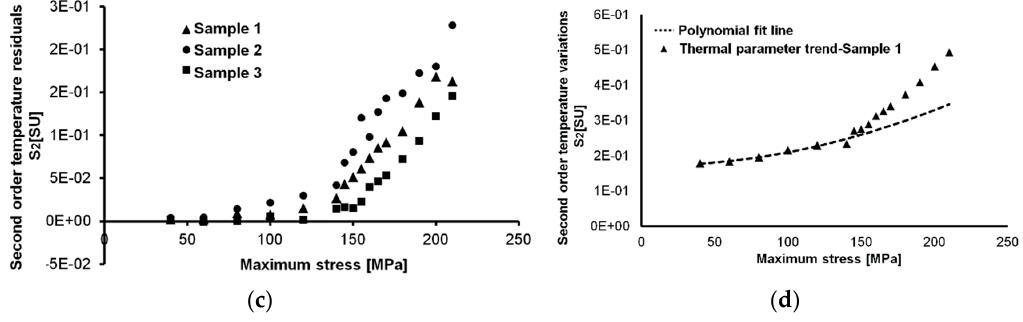
Figure 9. Linear Residuals of S 0 ( a ) and S 1 ( b ) parameters, and polynomial residuals of S 2 parameter ( c ), example of the polynomial fit line adopted for analysing sample 1 ( d ).